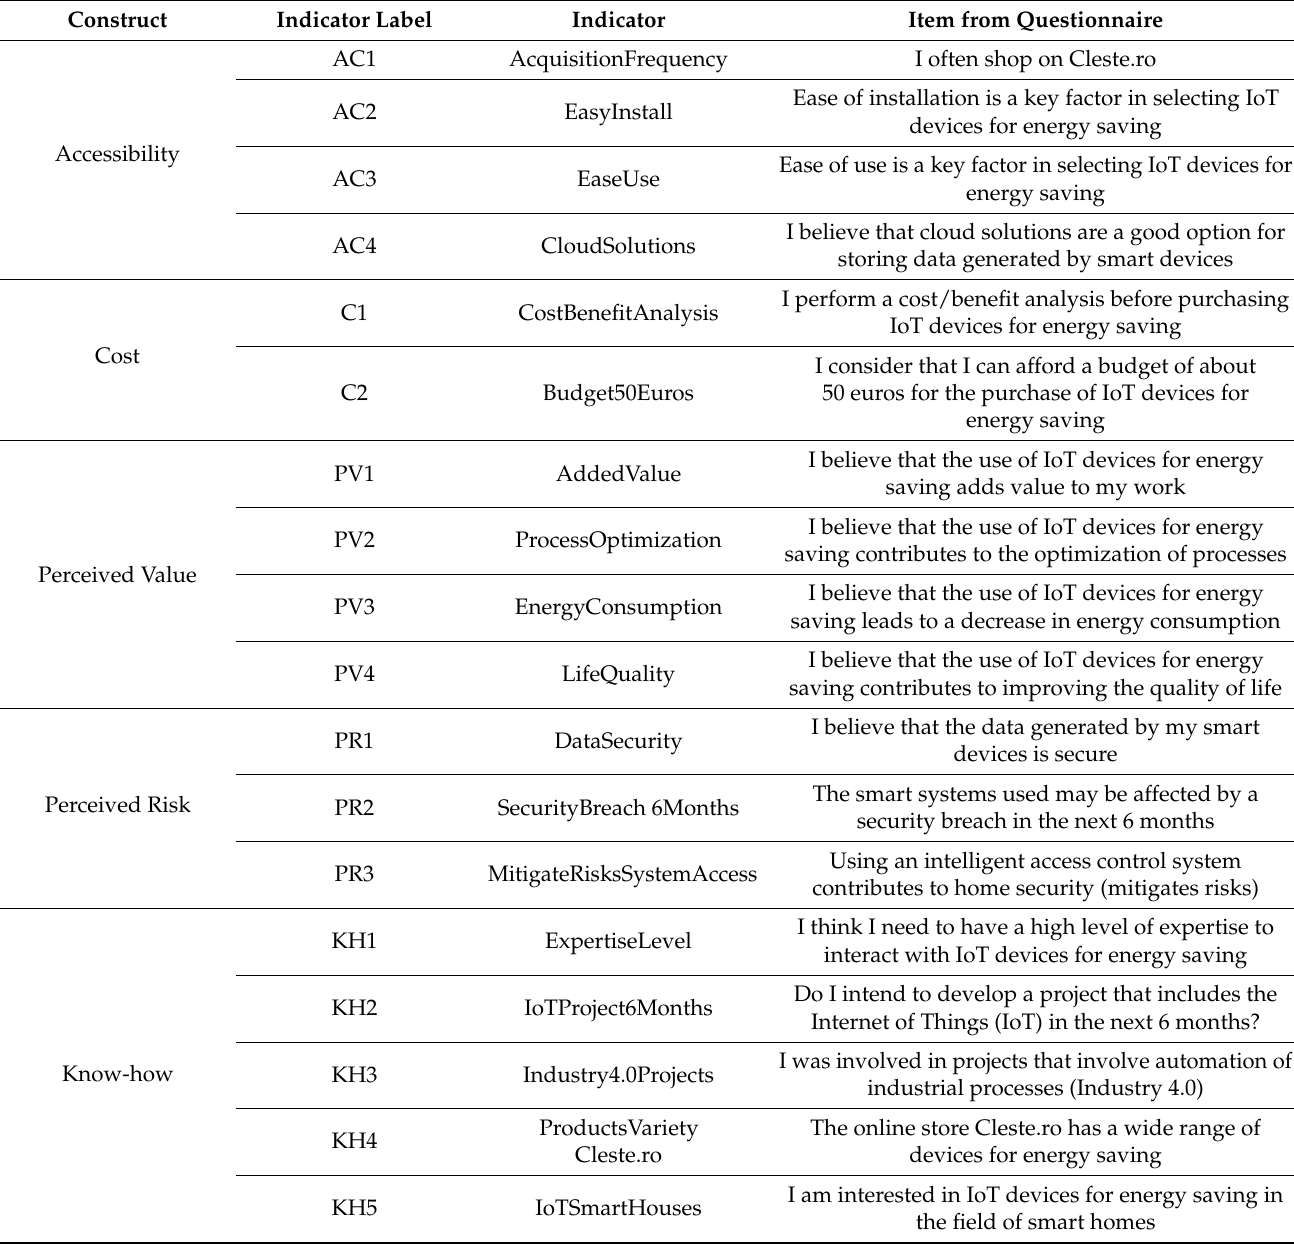
Table 1. Items included in the initial conceptual